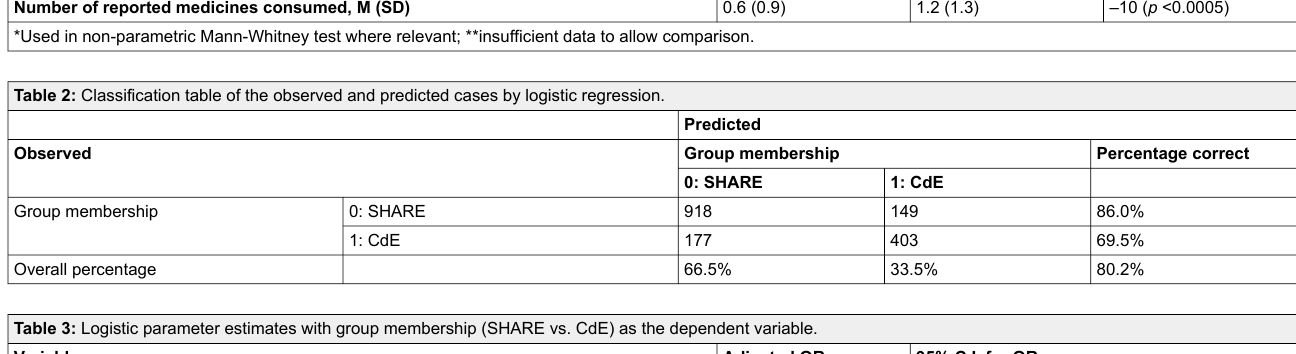
Table 3: Logistic parameter estimates with group membership (SHARE vs. CdE) as the dependent variable.